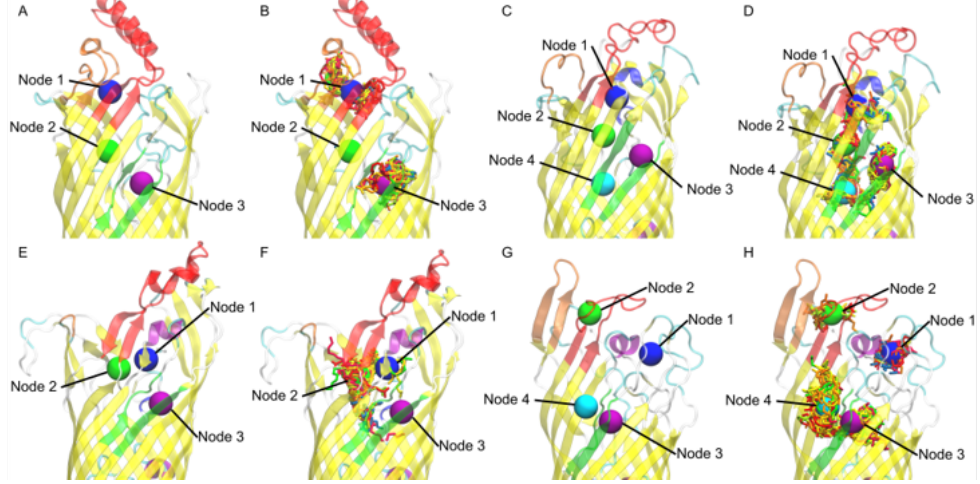
Figure 6. Nodal locations of: ( A ) E. coli b2344 ; ( C ) vc1042 ; ( E ) vc1043 ; ( G ) vca862 . Example frame of FA clusters versus mean shift generated nodes for: ( B ) E. coli ; ( D ) vc1042 ; ( F ) vc1043 ; ( H ) vca862